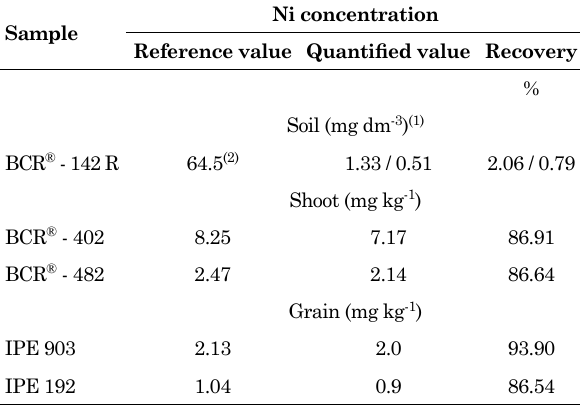
Table 2. Average of reference values and recovery of certified samples used to set the methods